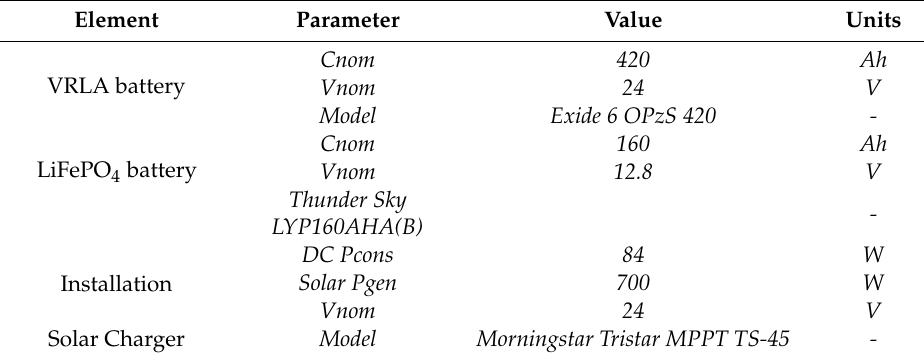
Figure 15. Di ff erent elements in the HESS installation. Figure 15 . Different elements in the HESS installation. Table 2. Installation Table 2. Installation features.